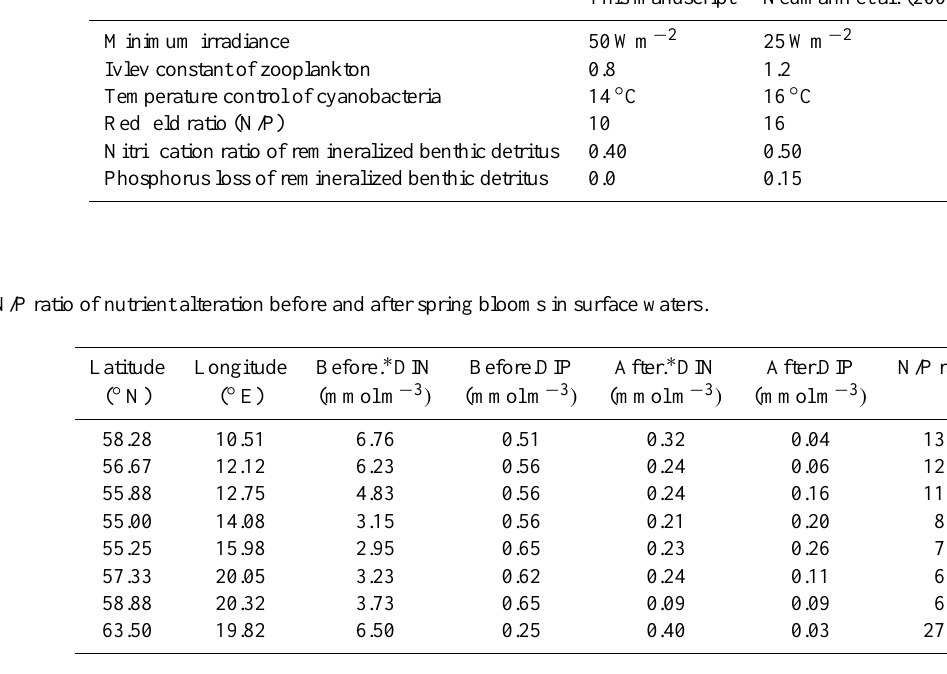
Table 1. Parameter values used in this study and those used by Neumann et al. (2002) Parameter Value Value This manuscript Neumann et al. (2002) Minimum irradiance 50Wm − 2 25Wm − 2 Ivlev constant of zooplankton 0.8 1.2 Temperature control of cyanobacteria 14 ◦ C Redfield ratio (N/P) Nitrification ratio of remineralized benthic detritus 0.40 Phosphorus loss of remineralized benthic detritus 0.0 0.15